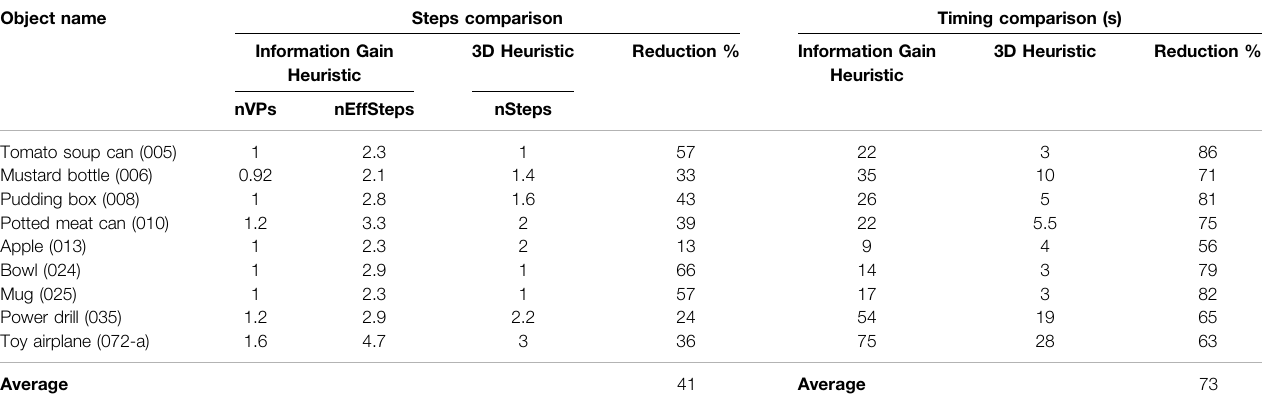
TABLE 1 | Comparison between the exploration pattern employed by the Information Gain Heuristic and the 3D Heuristic ’ s grasp weighted exploration.